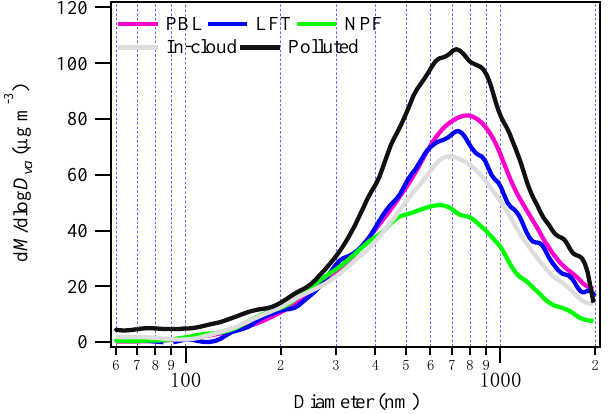
Figure 5. The MSDs and proportions of chemical species in differ- ent